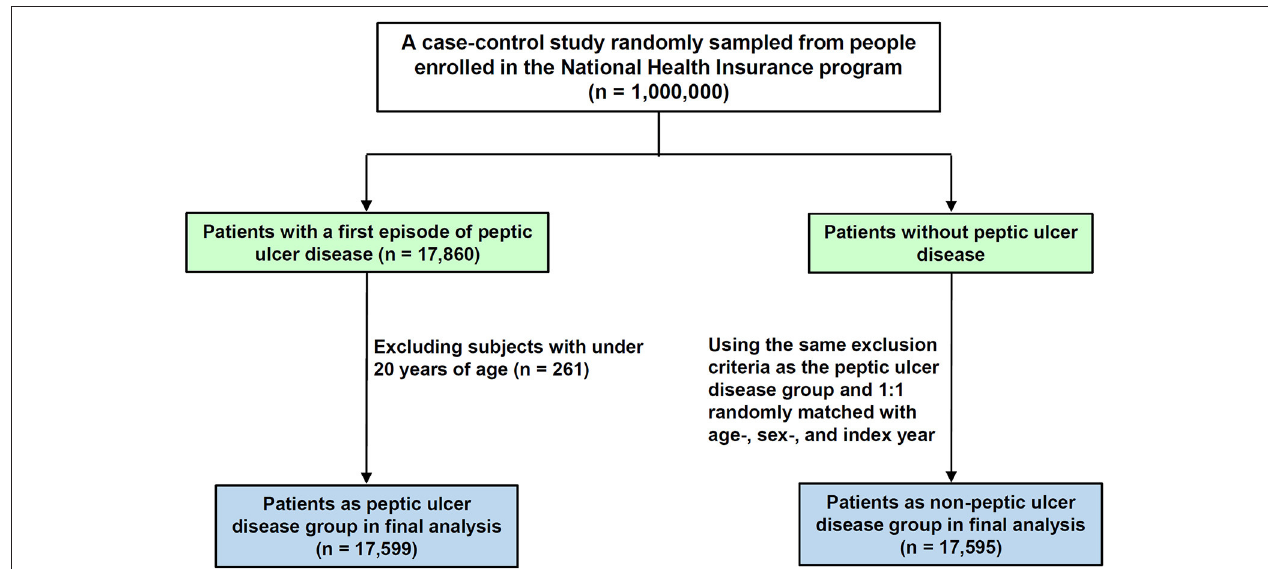
FIGURE 1 | Flowchart of the patient identification and